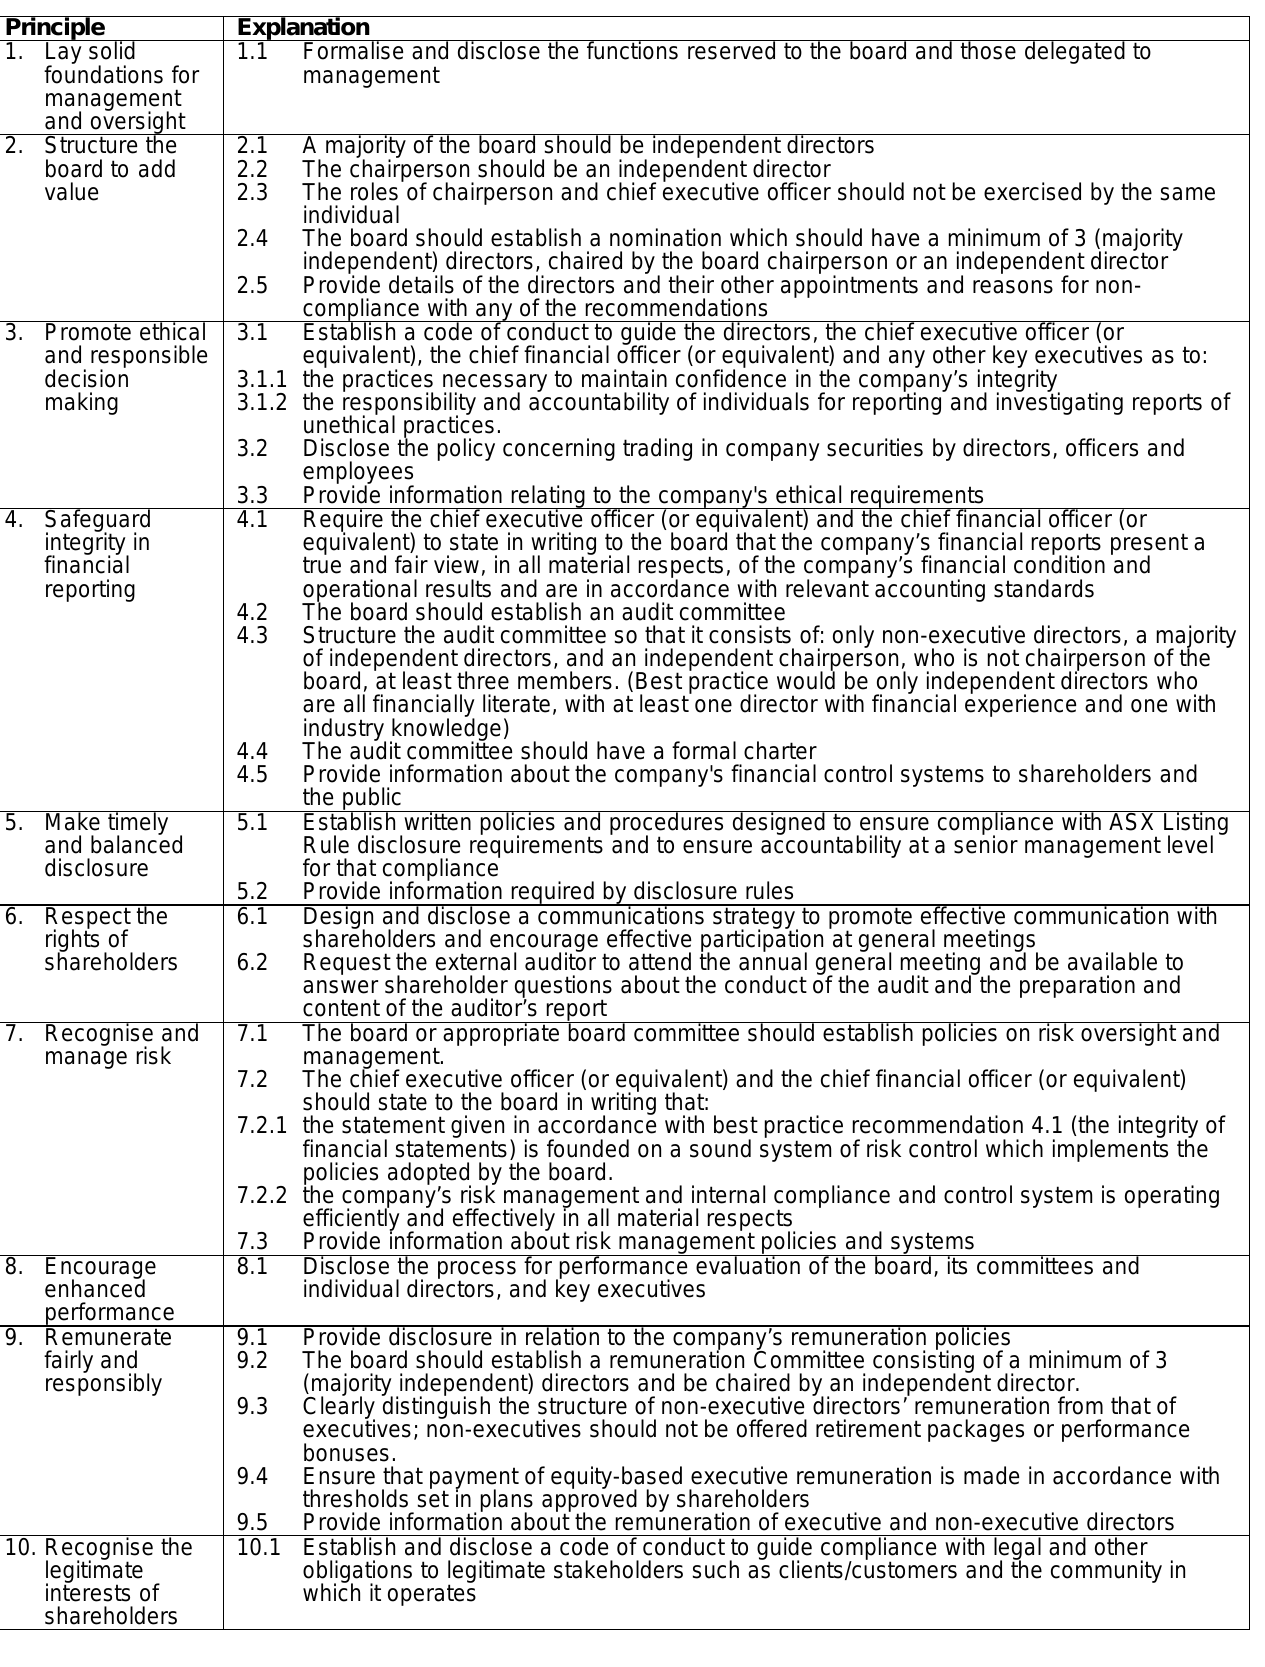
Table 1: ASX 10 core principles of good corporate